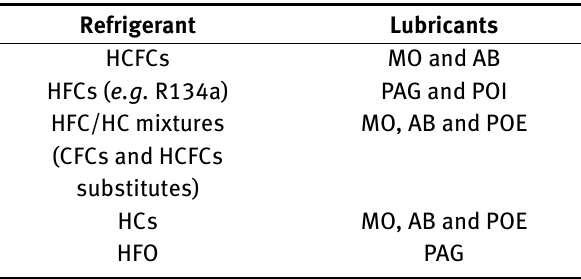
Table 1: Recommended lubricants for different refrigerant